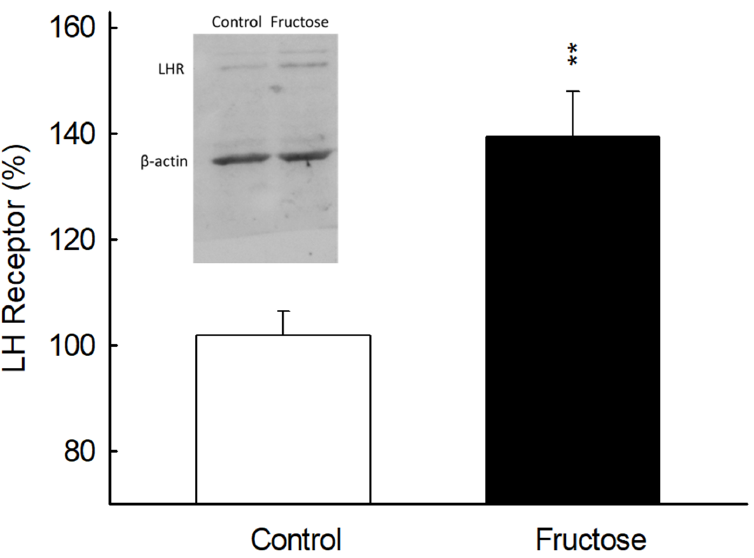
Figure 7. The expression of LH receptors in rat Leydig cells. The protein expression of membrane LH receptors in Leydig cells purified from the control group (white column)and fructose-diet fed group (black column) was examined by Western blot analysis. The intensities of LH receptor bands were adjusted to β actin. Each value represents mean ± SEM. ** p < 0.01 as compared to the control group. Similar results were repeated